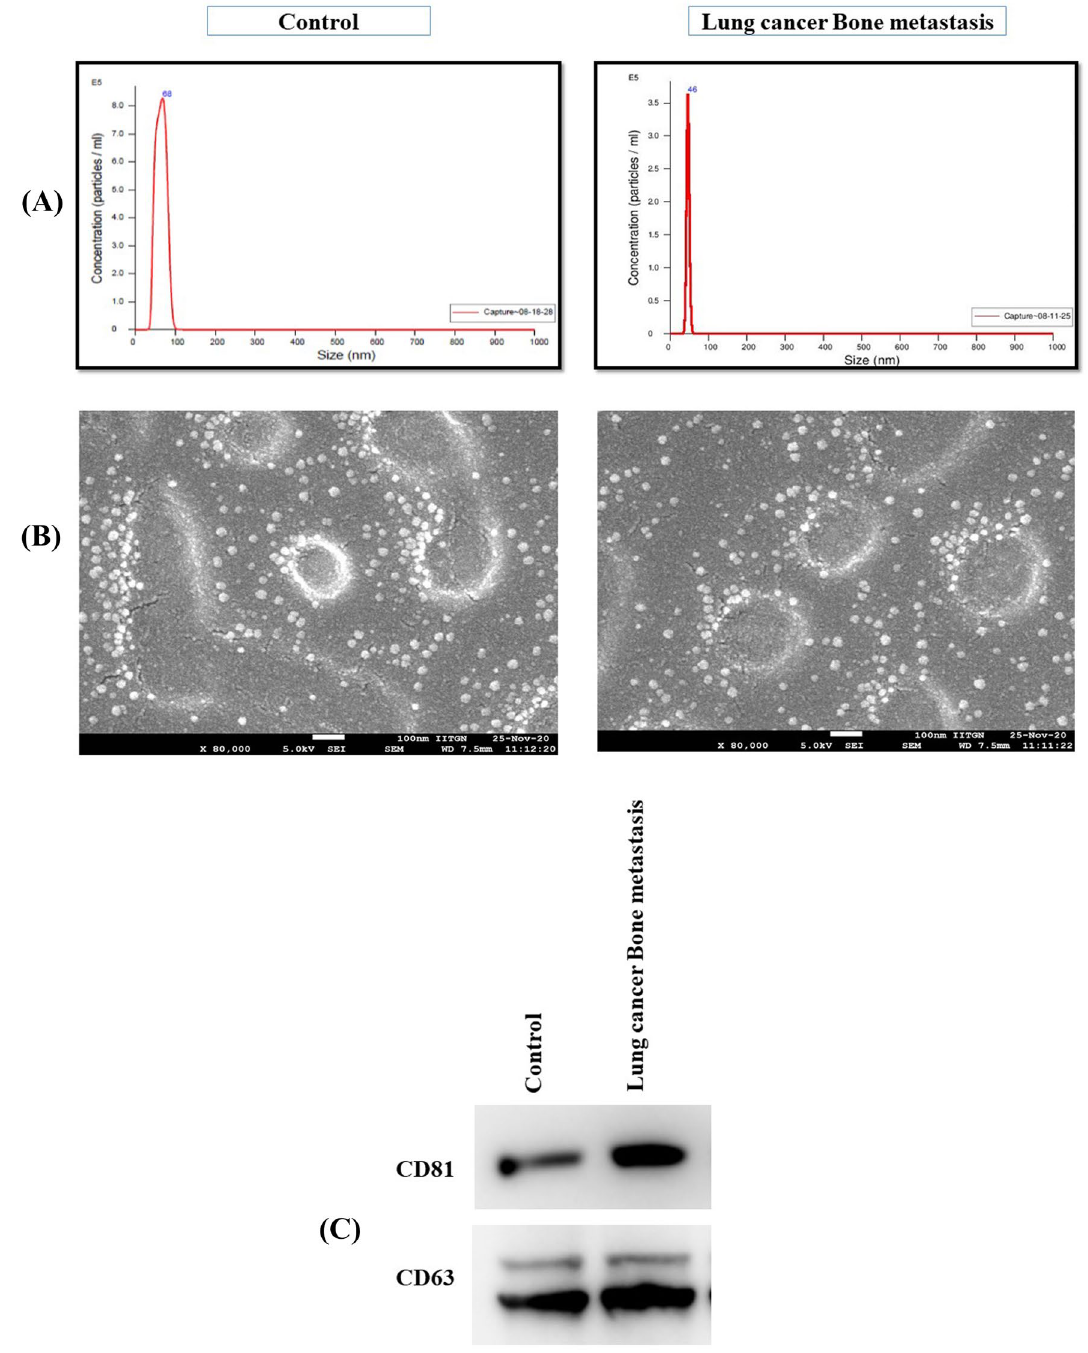
Figure 3. Characterization of extracellular vesicles using NTA, AFM and Westernblot. ( A ) Assessment of size and concentration of serum EVs from health person and lung cancer bone metastasis patients using Nanoparticle Tracking Analysis (NTA). The x-axis indicates the size distribution of particles and the y-axis shows the relative concentration (particles/ml) in NTA; ( B ) Representative AFM images of EVs from healthy person and lung cancer bone metastasis patient sera (Scale: 100 nm); ( C ) Western blot analysis of EVs isolated from serum of healthy individual and lung cancer bone metastasis patients to confirm the presence of classical common exosome markers (CD63 and